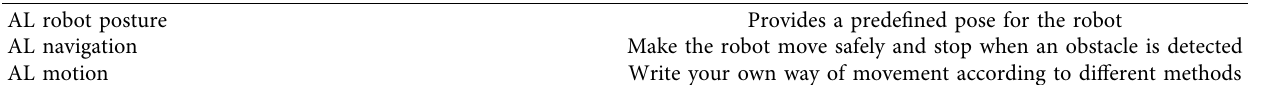
Table 2: Motion module function introduction.